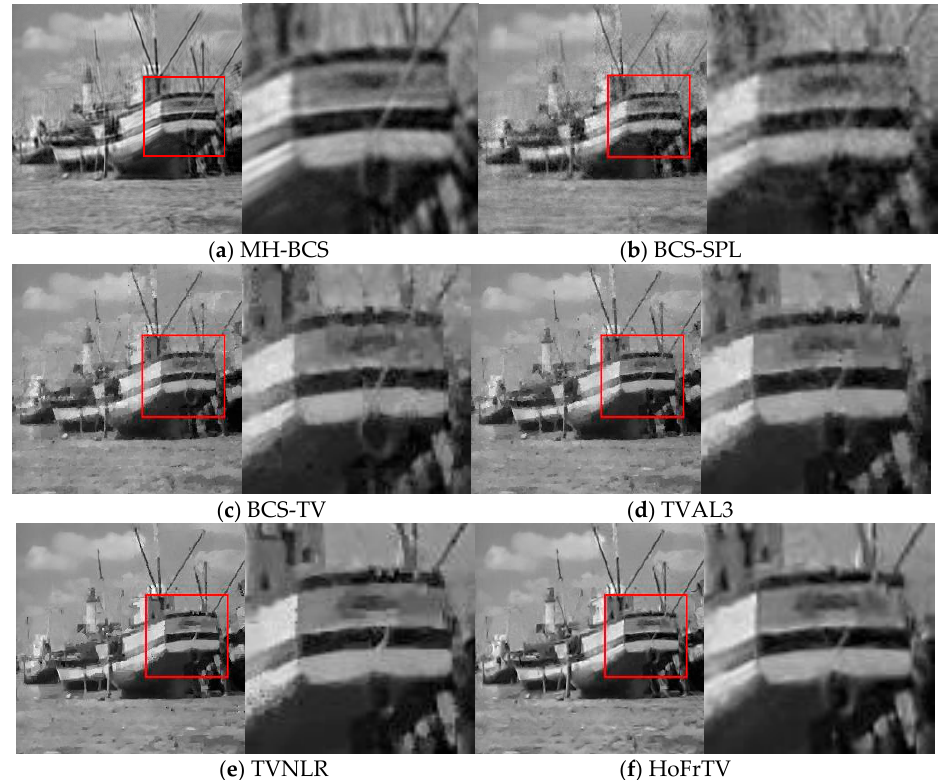
Figure 8. Reconstructed images (boat) for measurement rate = 0.2 ( a ) PSNR = 27.170 dB and SSIM = 0.796; ( b ) PSNR = 25.266 dB and SSIM = 0.697; ( c ) PSNR = 26.013 dB and SSIM = 0.758; ( d ) PSNR = 26.421 dB and SSIM = 0.774; ( e ) PSNR = 26.476 dB and SSIM = 0.783; and ( f ) PSNR = 27.523 dB, and SSIM = 0.816 .